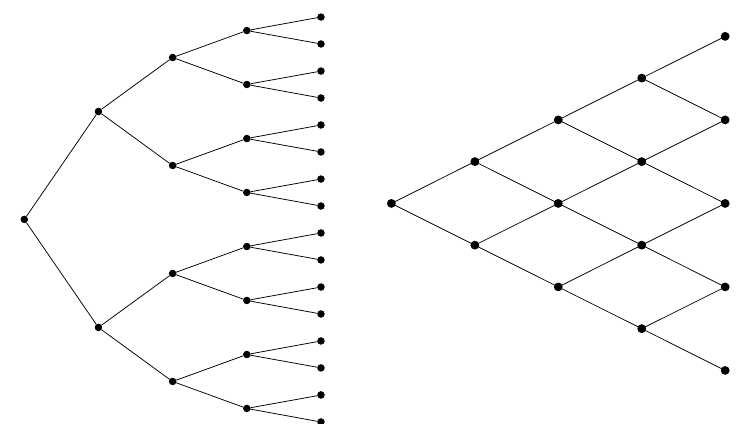
5 . (Left): General scenario tree. The number of =